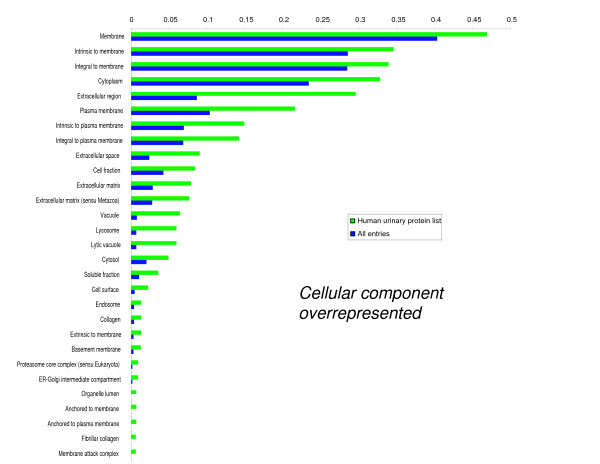
Significantly over-represented GO cellular component terms for the set of identified urinary proteins. The set of identified urinary proteins was compared with the entire list of IPI entries (IPI_Human, version 3.13, 57050 protein sequences), and significantly over-represented and underrepresented GO terms (P < 0.001) are shown. The ratio shown is the number of urinary and entire IPI proteins annotated to each GO term divided by the number of urinary and entire IPI proteins linked to at least one annotation term within the indicated GO cellular component, molecular function, and biological process categories. GO, Gene Ontology; IPI, International Protein Index.